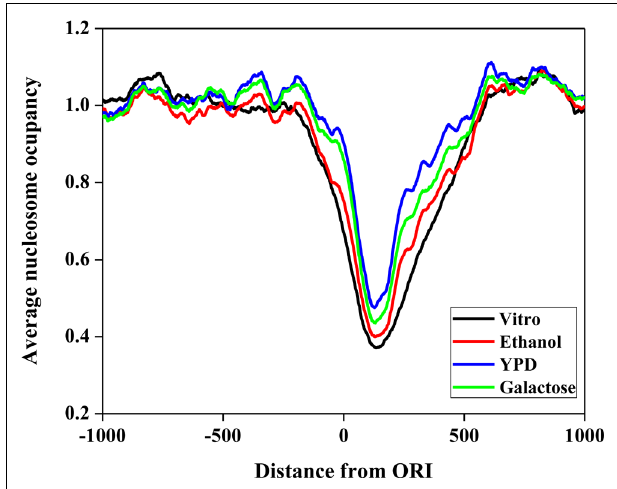
FIGURE 3 | Nucleosome occupancy around ORIs. The black curve represents the in vitro data.The red, blue, and green curves represent in vivo experimental maps for three growth conditions (ethanol, yeast extract, peptone, and dextrose medium [YPD] and galactose).